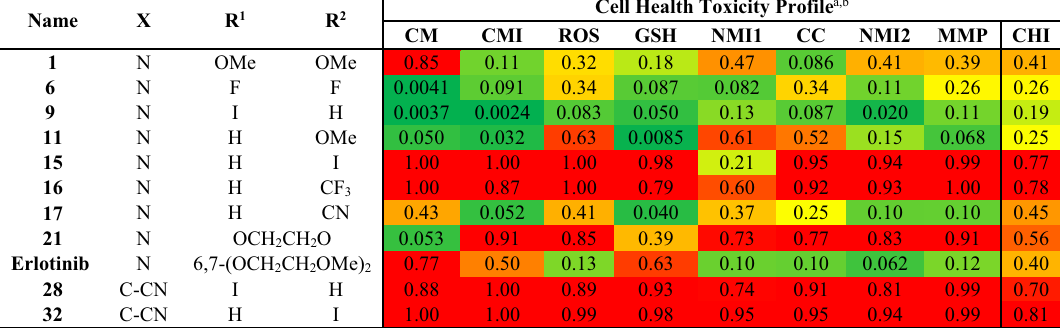
Table 4. Toxicity profiling of the initial screening hits. a Abbreviations from columns left to right. CM: Cell morphology; CMI: Cell membrane integrity; ROS: Reactive superoxide species; GSH: Glutathione; NMI1: Nuclear membrane integrity 1; CC: Cell Cycle; NMI2: Nuclear membrane integrity 2; MMP: Mitochondrial membrane depolarization; CHI: Cell Health Index. b All n =